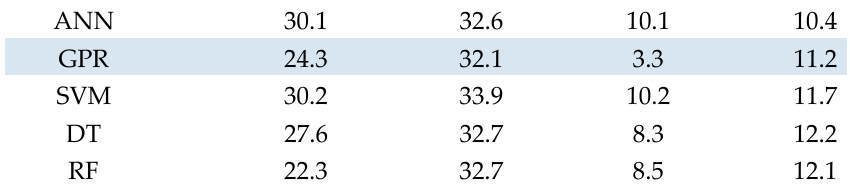
Table 1. RMSE of the five AI techniques for building heating load and natural gas consumption